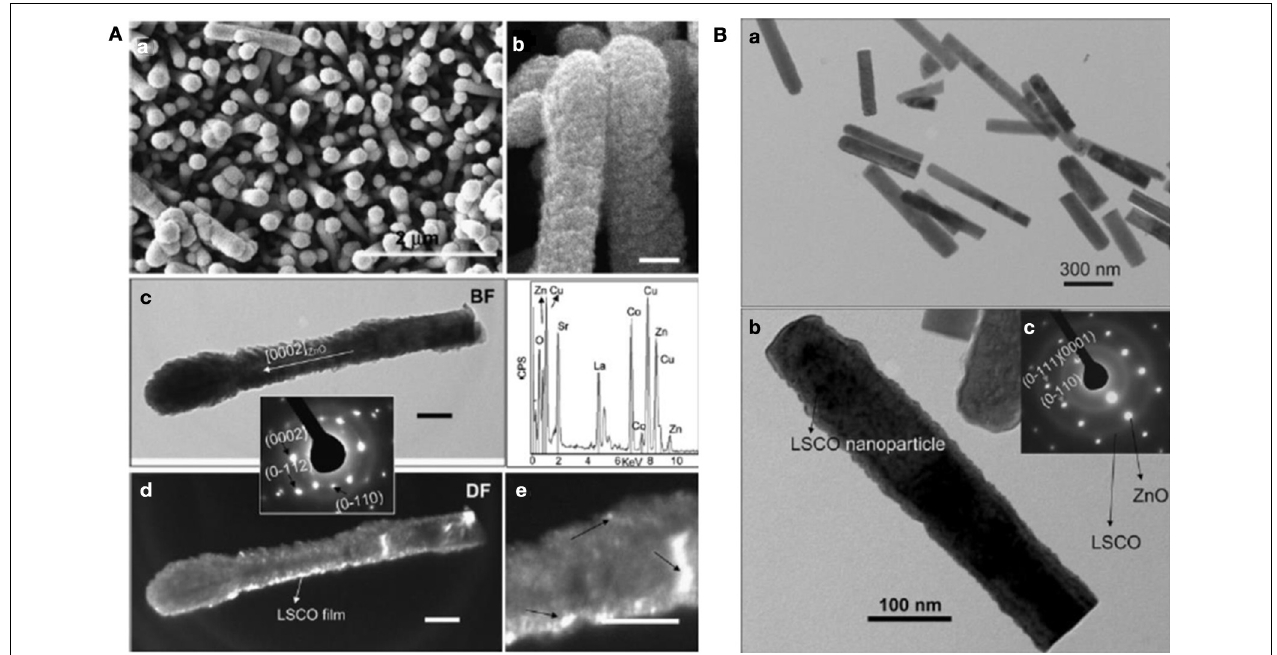
FIGURE 6 | Electron microscopy characterization of ZnO/LSCO composite nanorod arrays prepared by (A) Pulsed laser deposition; (B) sol-gel solution method. [Reprinted with permission of reference Jian et al. (2009). Copyright 2009 Royal Society of Chemistry].